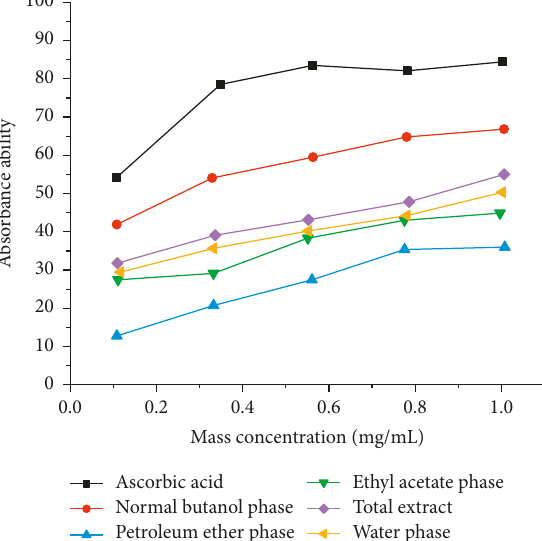
Figure 3: The reducing ability of different extraction parts of horsetail ethanol extract ( n � 3).